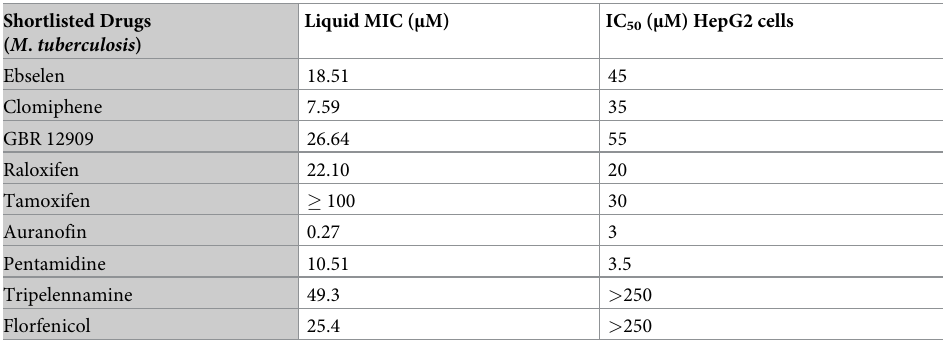
MICs were determined in liquid growth media using the Alamar Blue assay (S4 Fig). Cytotoxicity IC 50 values against HepG2 cell were determined using the CellTitre-Glo (Promega) assay. Experiments were carried out at least three independent times and representative data are